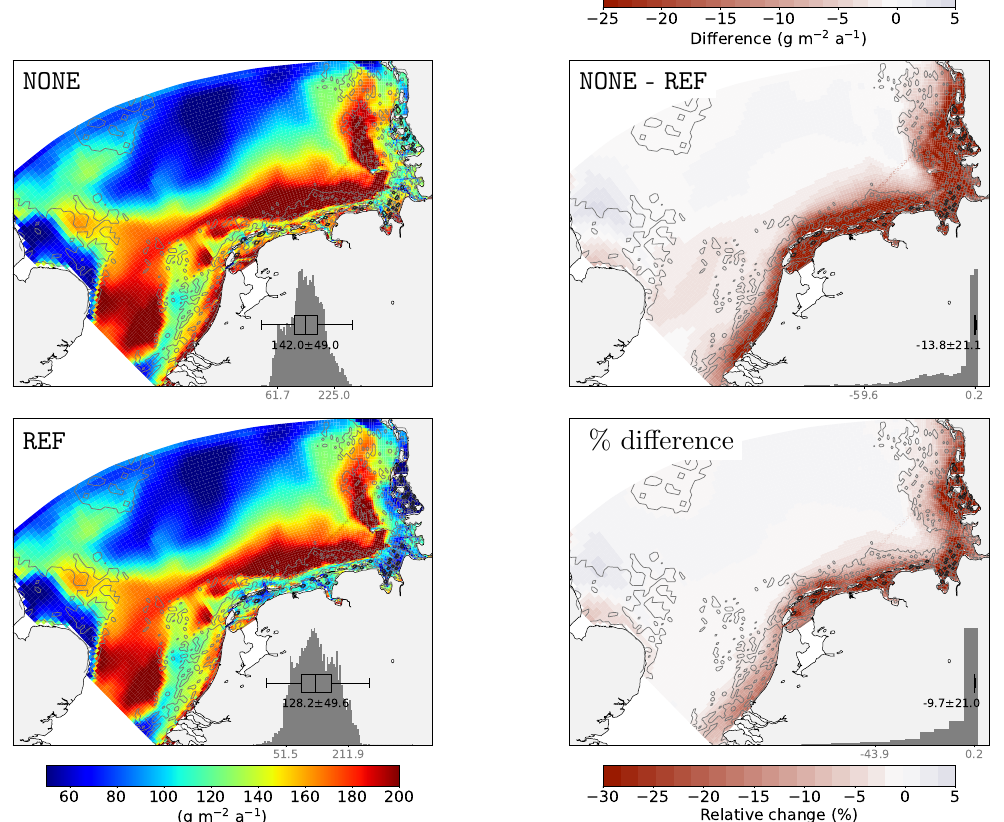
Figure 6. Simulated net primary productivity, climatologically averaged (2003–2013) (left figures) for simulations including benthic filtration (REF) and without filtration (NONE). Absolute and relative differences are shown on the right. Annually resolved net primary productivity (NPP) and difference maps are available in the supporting online material as Figures